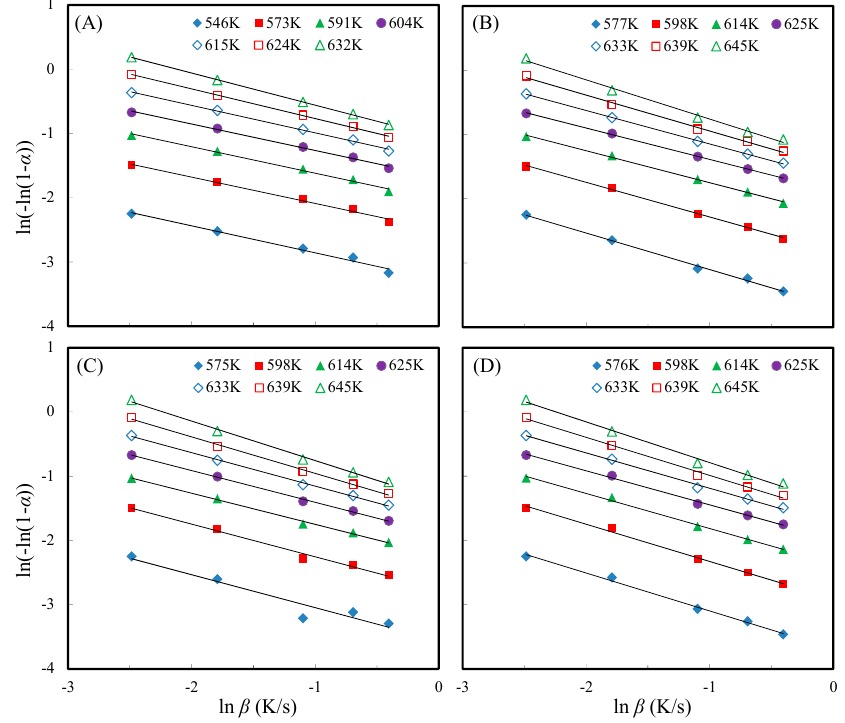
Figure 8. Regression lines to reaction order proposed by Avrami theory for unmodified slicewood ( A ); AA-acetylated slicewood (WPG 18%) ( B ); and VA-acetylated slicewood (cWPG 18%) with PC ( C ) and PA ( D ).